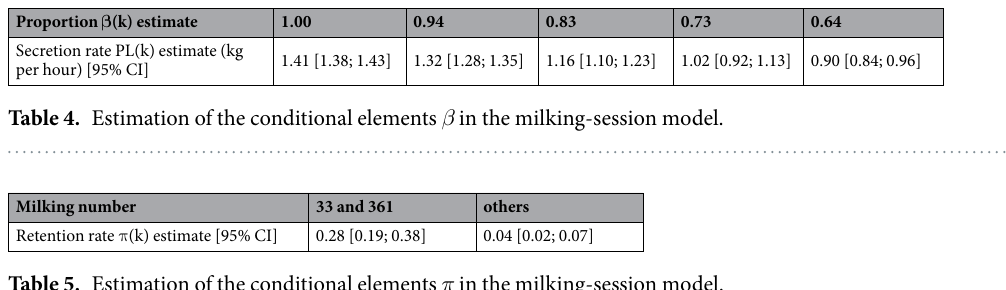
Table 5. Estimation of the conditional elements π in the milking-session